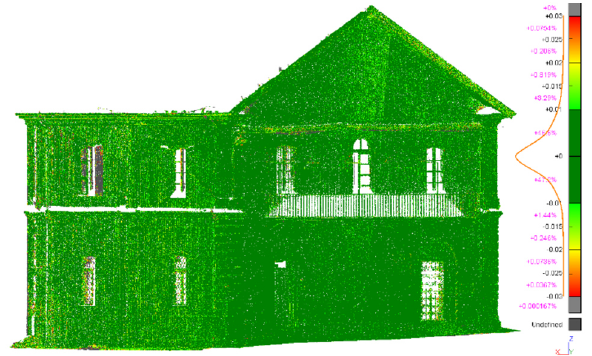
Figure 14. Plan section (A - top) and cross section (B - bottom) of the north façade of the barracks. The coloured lines represent the section extracted from the models generated using: DJI Spark (in green), Leica BLK360 (in blue) and the Faro Focus 330 (in